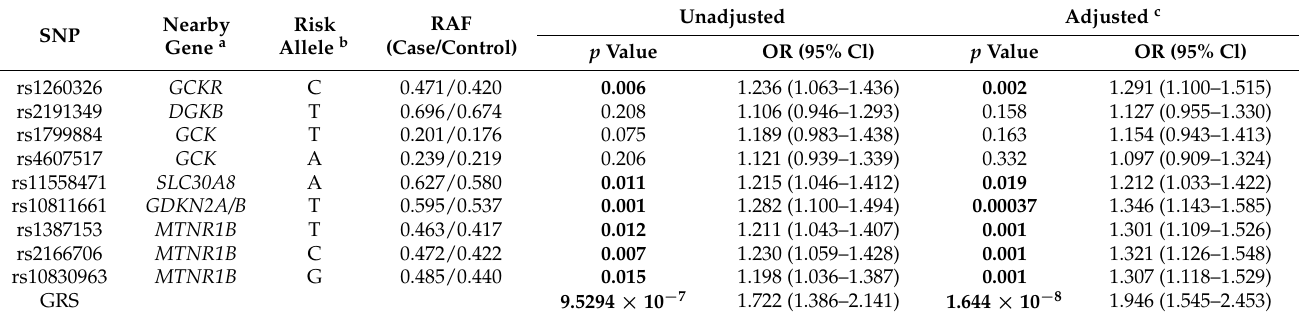
Table 2. Association of nine SNP loci with the normal versus prediabetes and T2DM